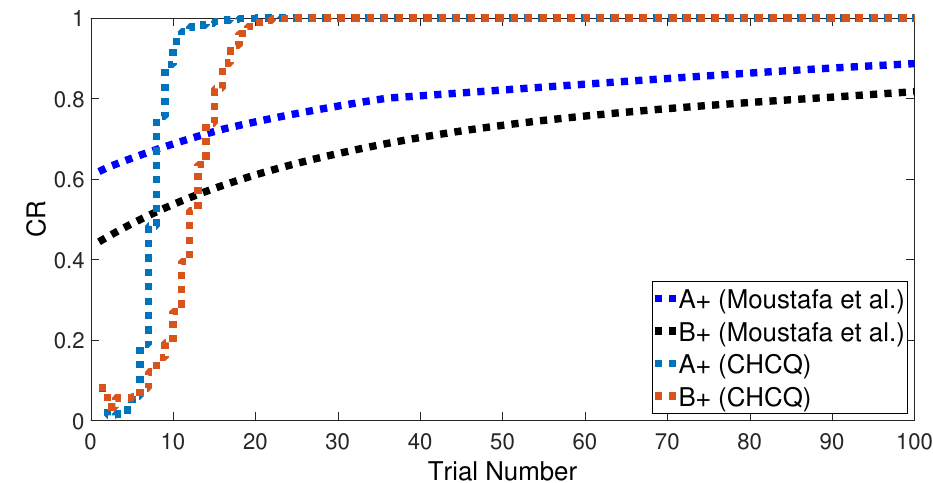
Figure 15. Overshadowing task for the lesioned system.